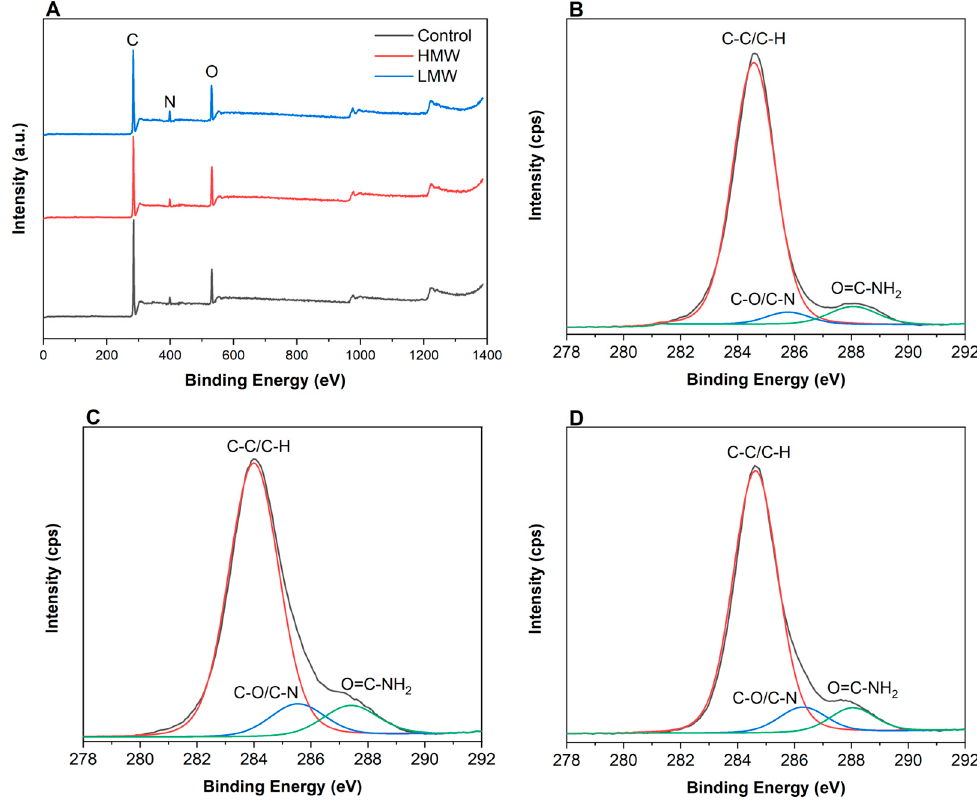
Figure 4. XPS survey spectra of ( A ) all samples and XPS of C 1s features for ( B ) control scaffolds and collagen scaffolds with ( C ) HMW chitosan and ( D ) LMW chitosan.